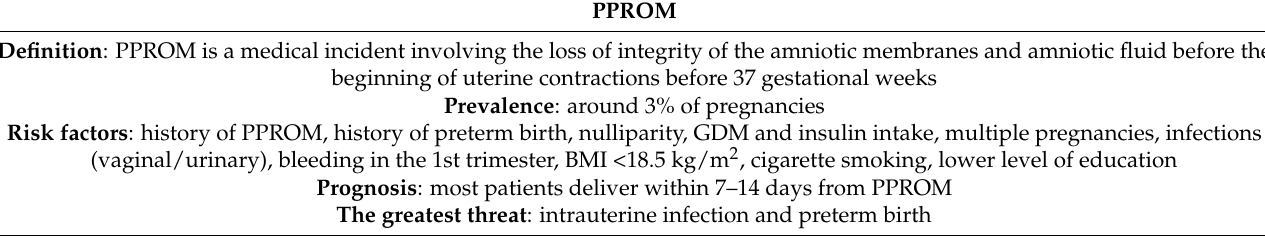
Table 3. Summary of